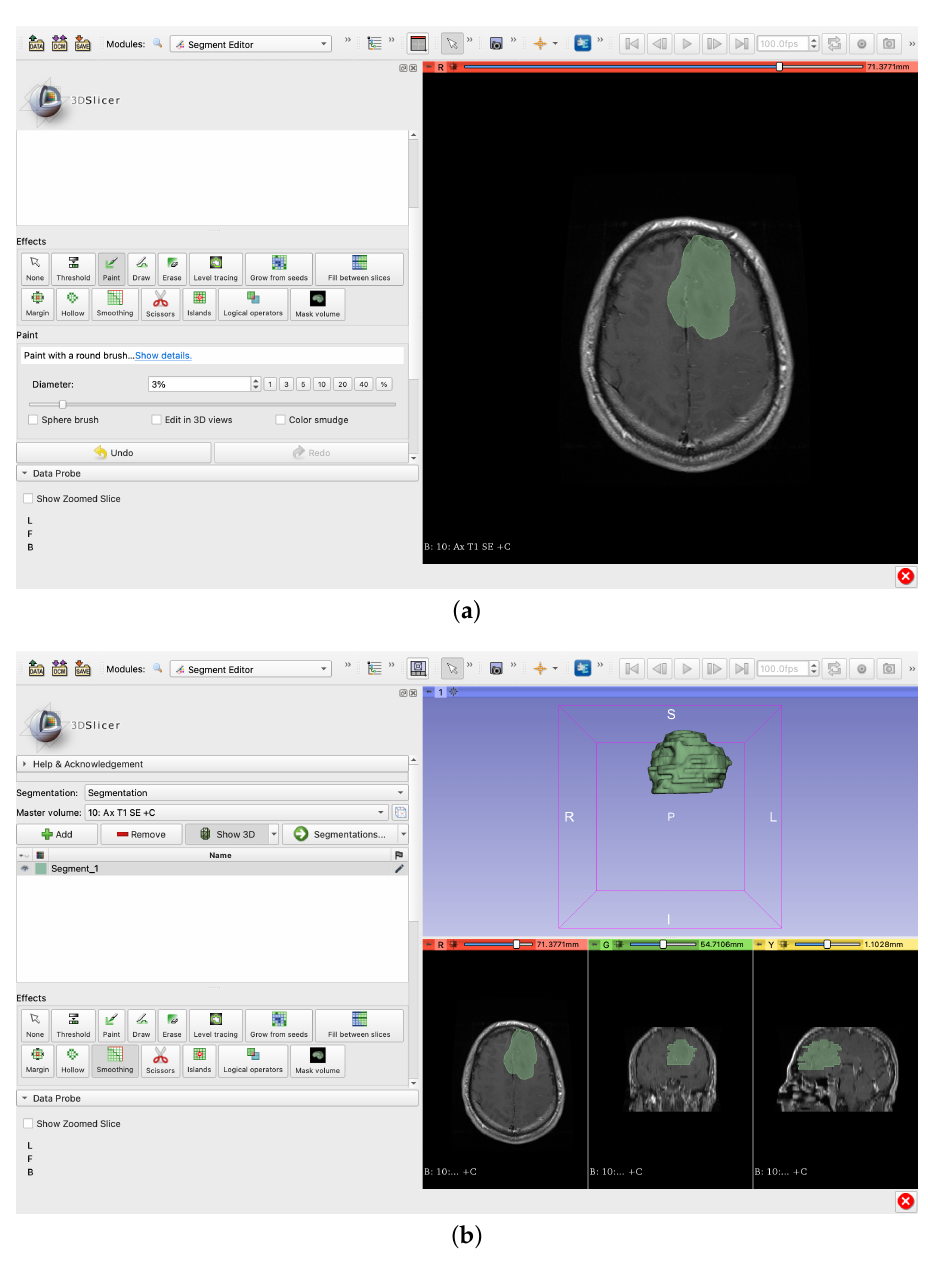
Figure 11. Experimental assessment, third patient. Segmentation with slicer 3D ( a ) coronal, sagittal, transversal, and 3D visualization, ( b ) only transversal visualization, the light green area represents the